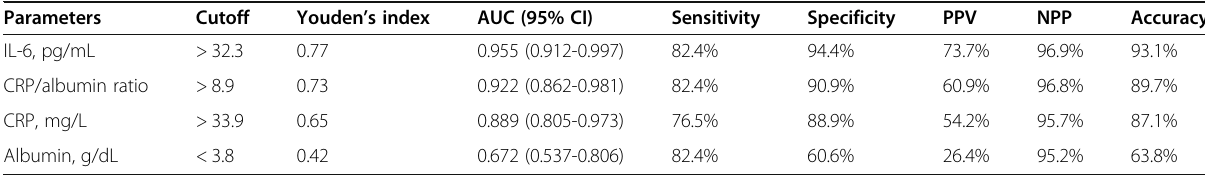
Table 2 The performance criteria of the laboratory markers in discriminating the severity of COVID-19